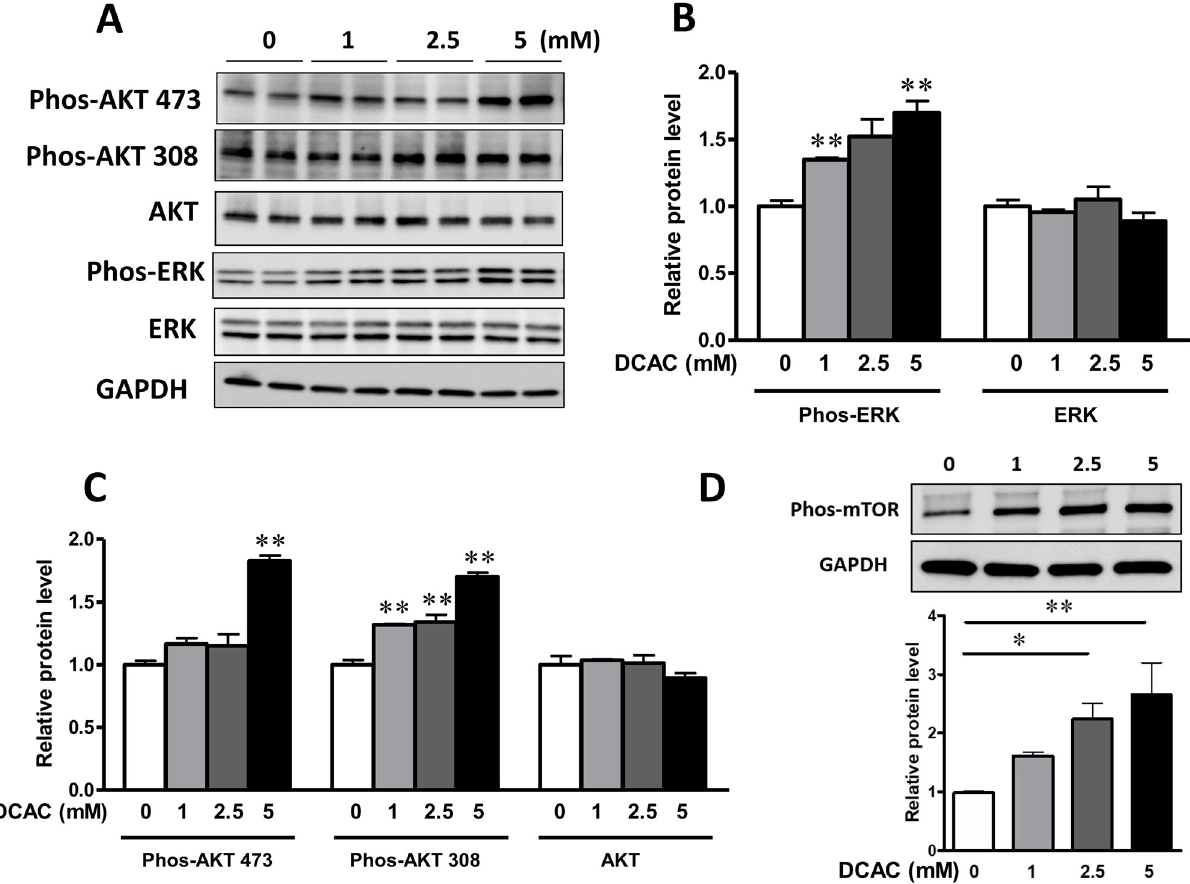
Fig 5. DCAC up-regulated the AKT/mTOR and MAPK signaling in KCs. KCs were pre-treated with DCAC at concentrations of 0, 1, 2.5 or 5 mM for 24 h. (A) Representative images of the cellular levels of phos-AKT S473, phos-AKT T308, total AKT, phos-ERK and ERK, as determined by Western blotting, (B) Relative phos-ERK level, as determined by Western blotting, (C) Relative protein levels of phos-AKT(Ser-473) and phos-AKT(Thr-308), as determined by Western blotting, and (D) Representative images and relative phos-mTOR, as determined by Western blotting. n = 3 in each group. � p < 0.05; �� p < 0.01, as compared to the